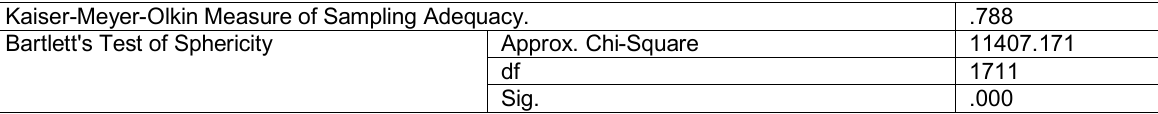
Table 3: KMO and Bartlett's